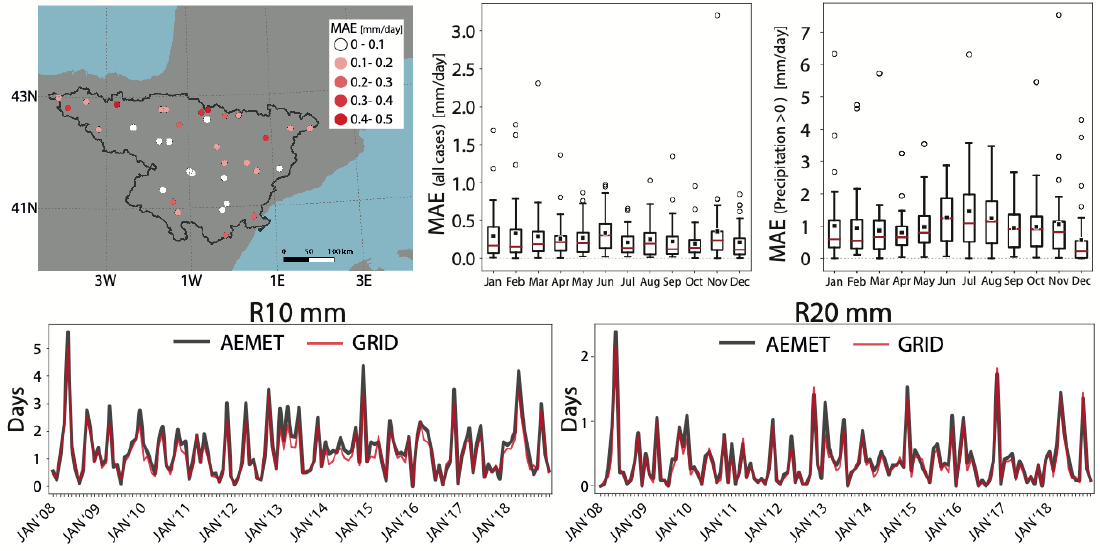
Figure 3. ( Top left ) Evaluation of interpolation performance at annual scale (mean). Boxplots of Figure 3. (Top left) Evaluation of interpolation performance at annual scale (mean). Boxplots of mean mean absolute error (MAE) at the monthly scale for all observations ( top center ) and rainy days absolute error (MAE) at the monthly scale for all observations (top center) and rainy days (top right). ( top right ). ( Bottom ) Time series of the mean R10 mm and R20 mm values for 34 stations and their (Bottom) Time series of the mean R10mm and R20mm values for 34 stations and their pixels in the pixels in the gridded data. R10 mm and R20 mm were computed using the following expression: gridded data. R10mm and R20mm were computed using the following expression: R10mm = (cid:80) R10 mm = R10mm cases in month for all stations/ Total Number of ∑ R10mm cases in month for all stations Total Number of stations⁄ .